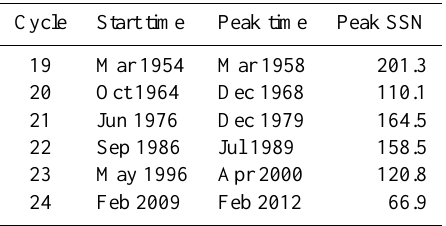
Table 1. The start time, peak time and peak sunspot number of SC19 to SC24. ∗